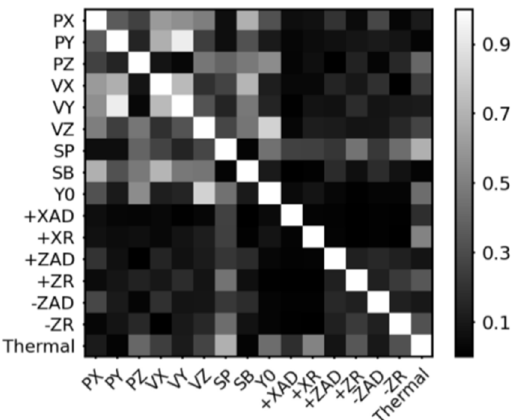
Figure 8. Correlations between the satellite state, ABW as well as the thermal scale factor k parameters of C13 on DOY 200, 2018 ( β angle of approximately 20 deg).